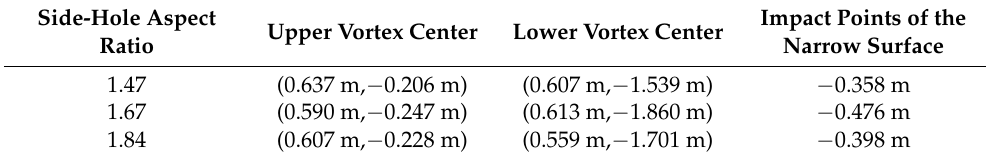
Figure 8. Locally amplified figure of the velocity vector with different SEN. ( a ) Aspect ratio of 1.47. ( b ) Aspect ratio of 1.67. ( c ) Aspect ratio of 1.84. Table 5. Upper and lower flow vortex core position and narrow surface impact position.